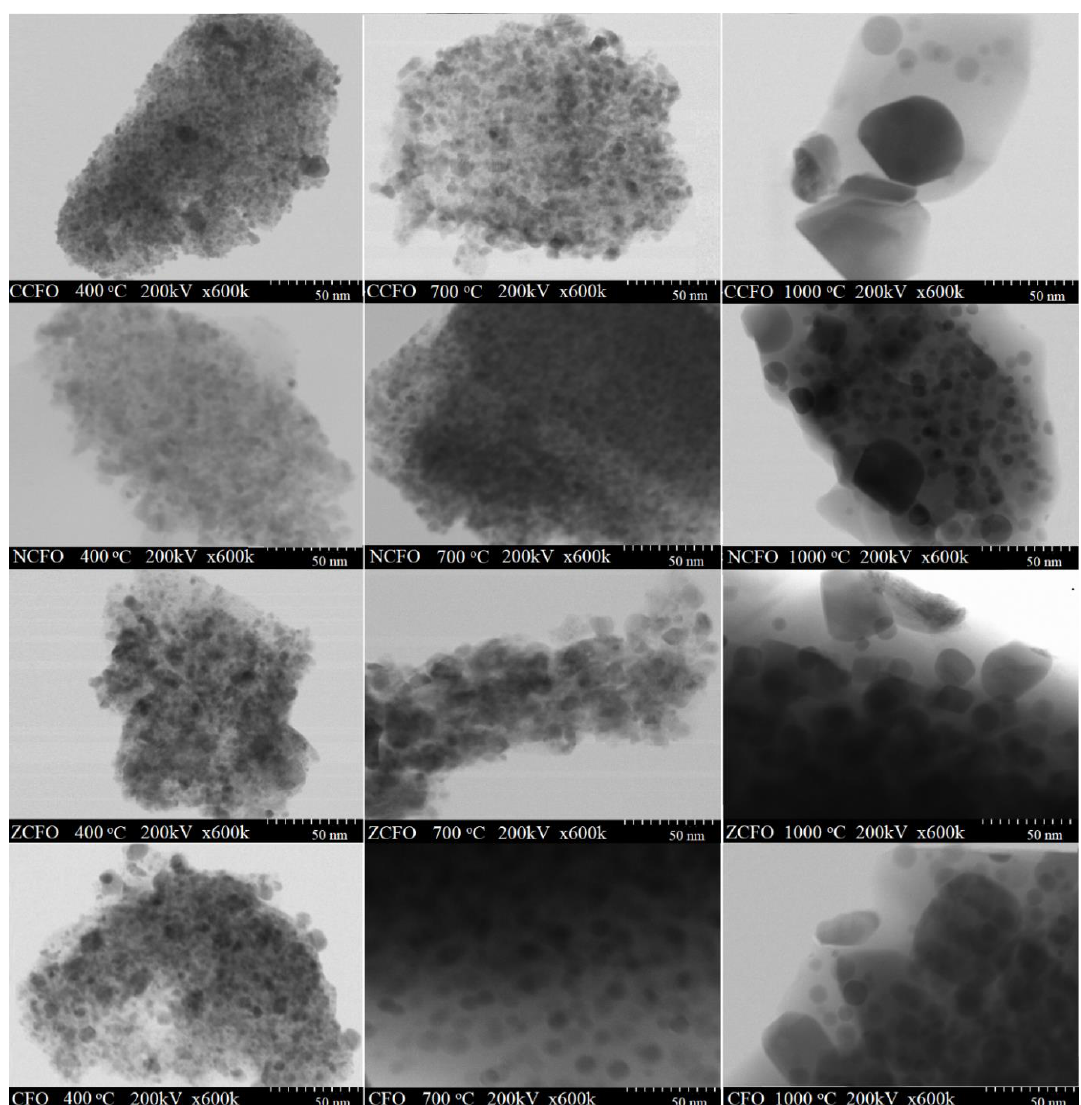
Figure 4. Transmission Electron Microscopy (TEM) images of CFO, ZCFO, NCFO, and CCFO annealed at 400, 700, and 1000 °C.